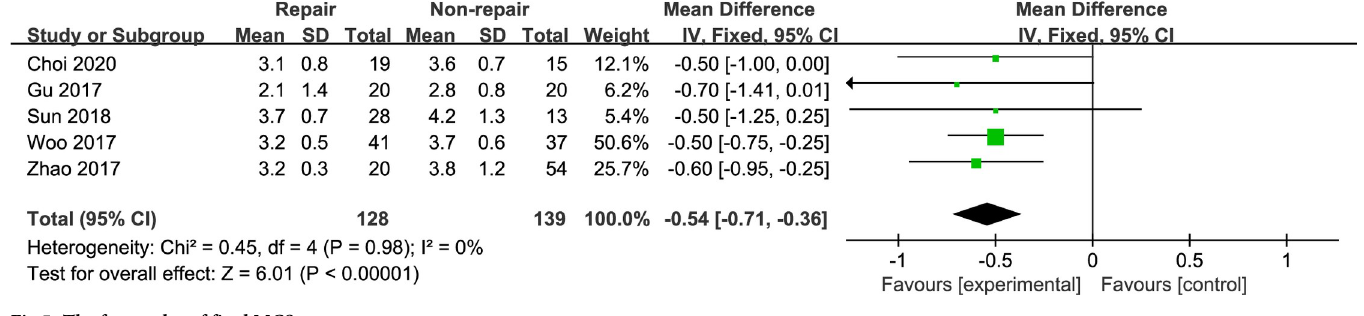
Fig 5. The forest plot of final MCS.